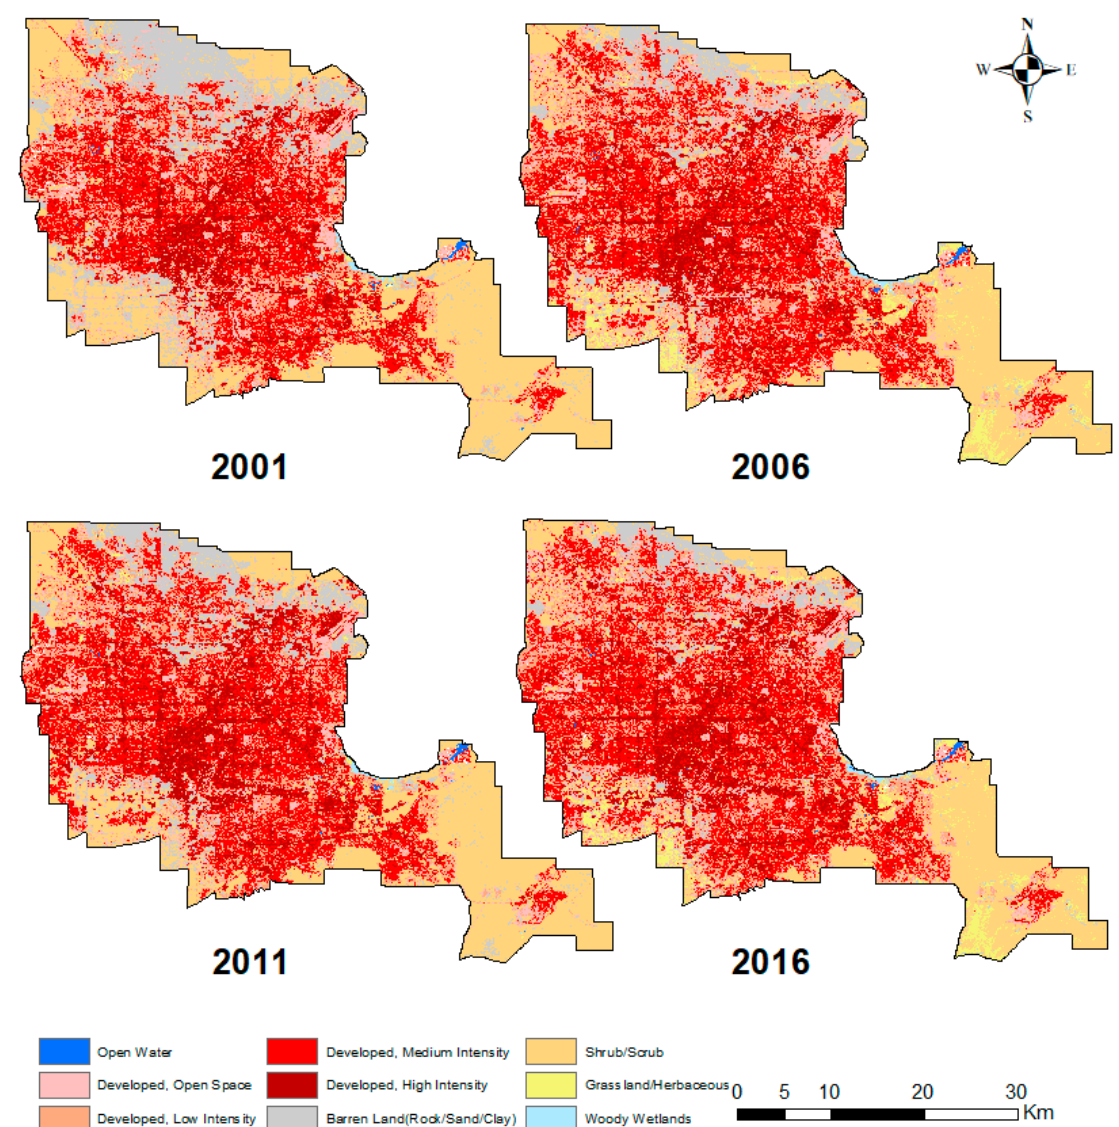
Figure 2. Land use land cover (LULC) maps of Las Vegas in 2001, 2006, 2011, and